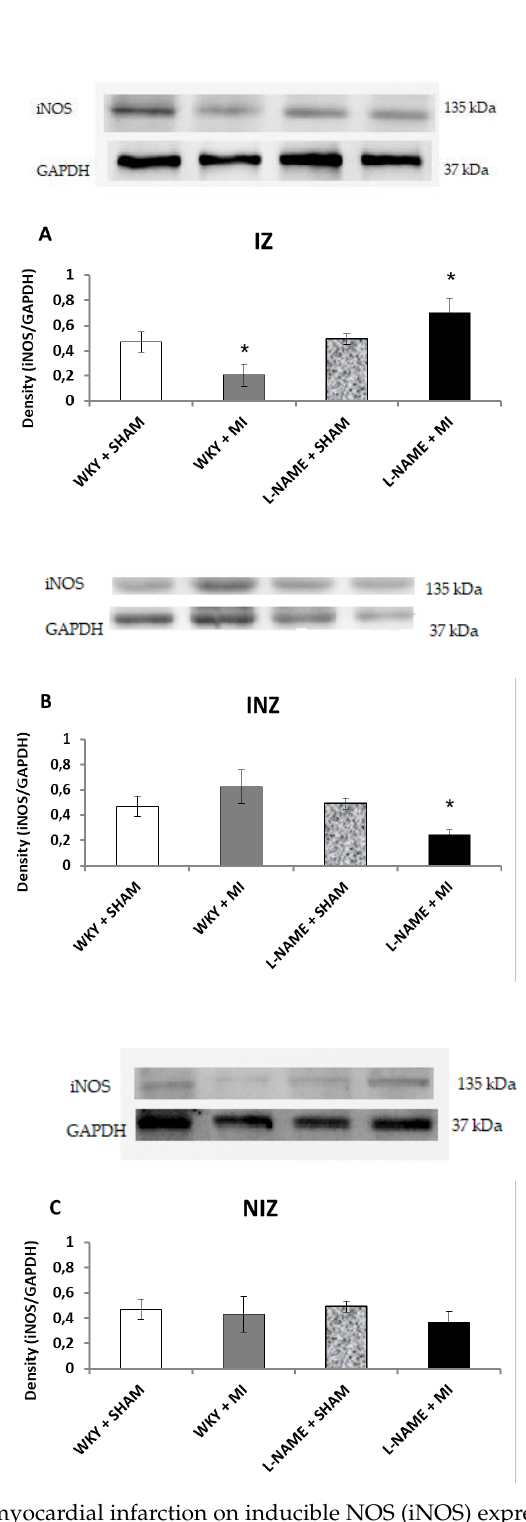
Figure 3. The effect of myocardial infarction on inducible NOS (iNOS) expression of infarcted zone (A), injured zone (B) and non-infarcted zone (C) of myocardium. Representative western blot images and relative iNOS expression levels of sham operated Wistar Kyoto rats (WKY + Sham); WKY rats with experimentally induced myocardial infarction (WKY + MI); sham operated WKY rats treated with L-NAME (20 mg / kg / day) (L-NAME + Sham) and L-NAME (20 mg / kg / day) treated WKY rats with experimentally induced myocardial infarction (L-NAME + MI) in infarcted zone (IZ) (A), injured zone (INZ) (B) and non-infarcted zone (NIZ) (C). * p < 0.05 compared to WKY + Sham group; N = 6 in each